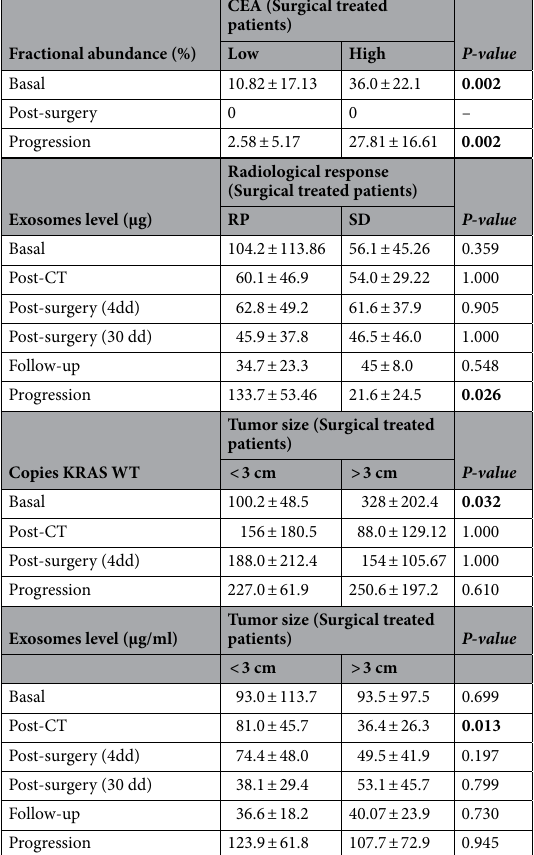
CEA (Surgical treated